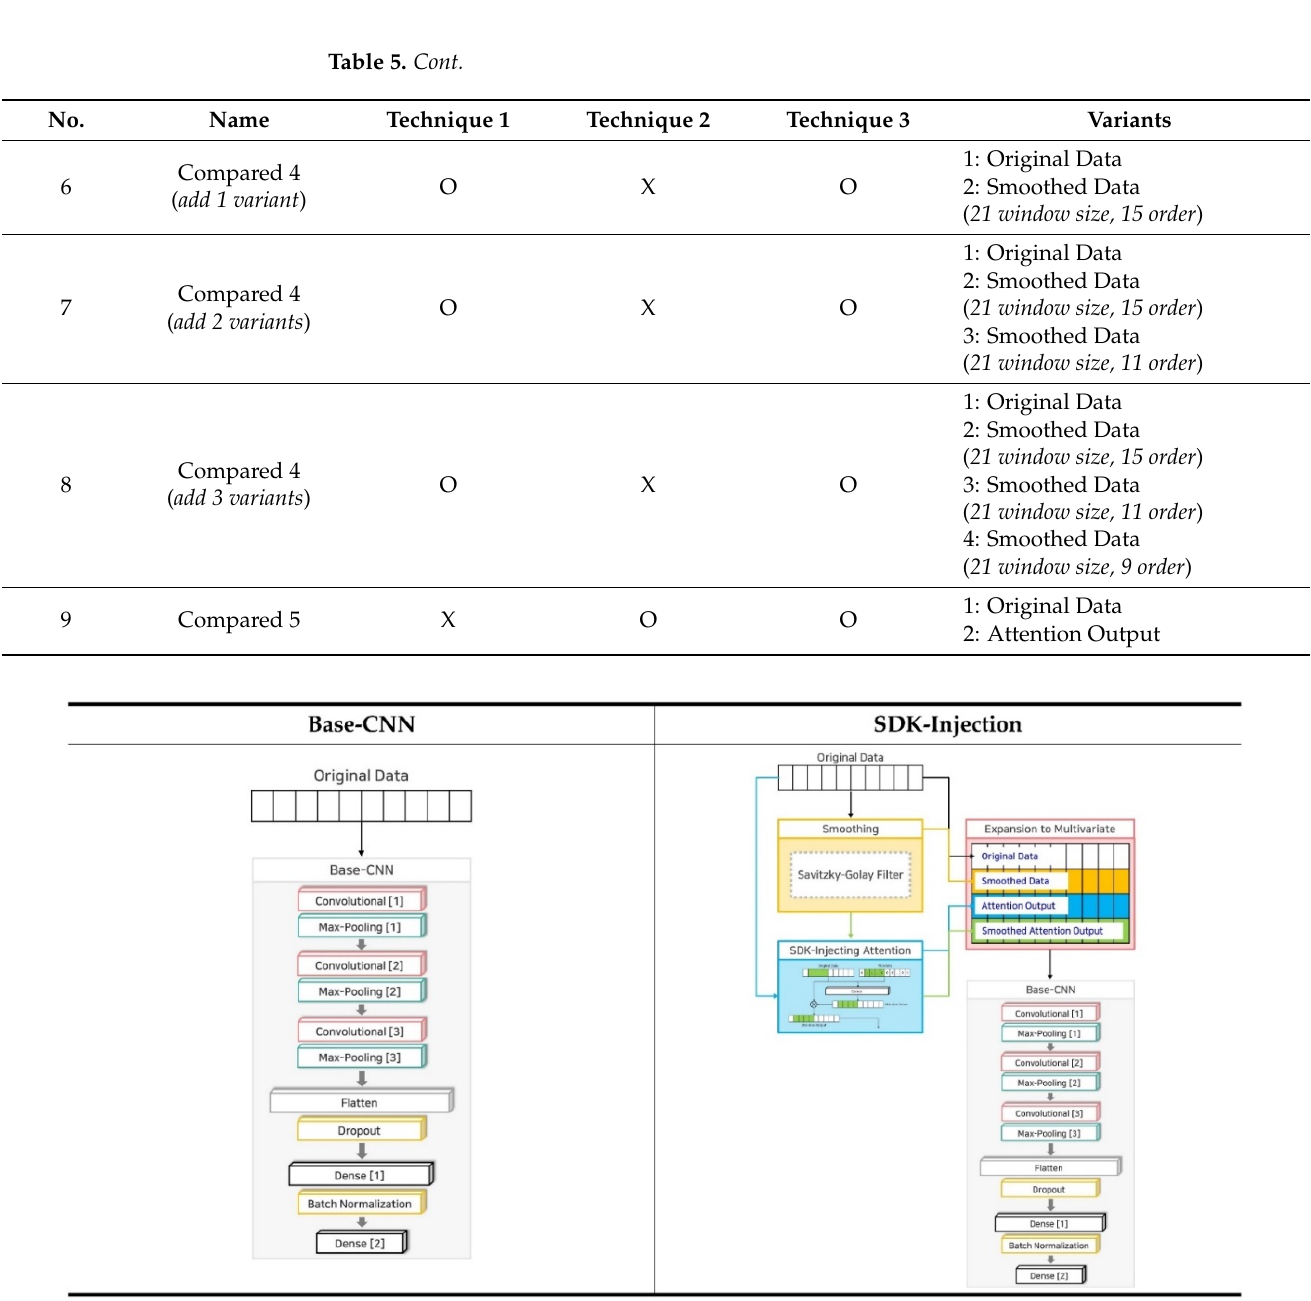
Figure 9. Schemes of SDK-Injection and other comparison method (Base-CNN) derived from the combination of three techniques.